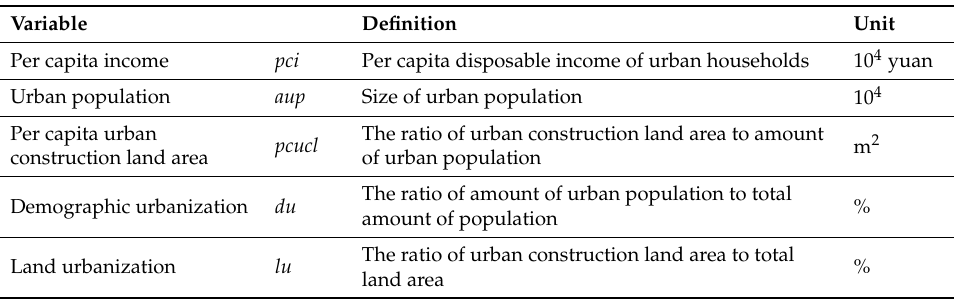
Table 2. Definition of independent